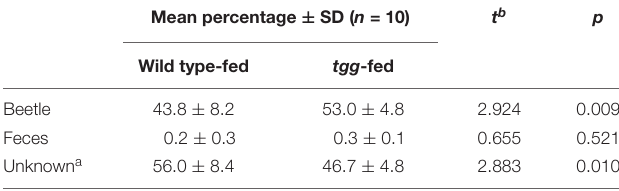
TABLE 1 | Recovery of ingested allyl glucosinolate in P. armoraciae